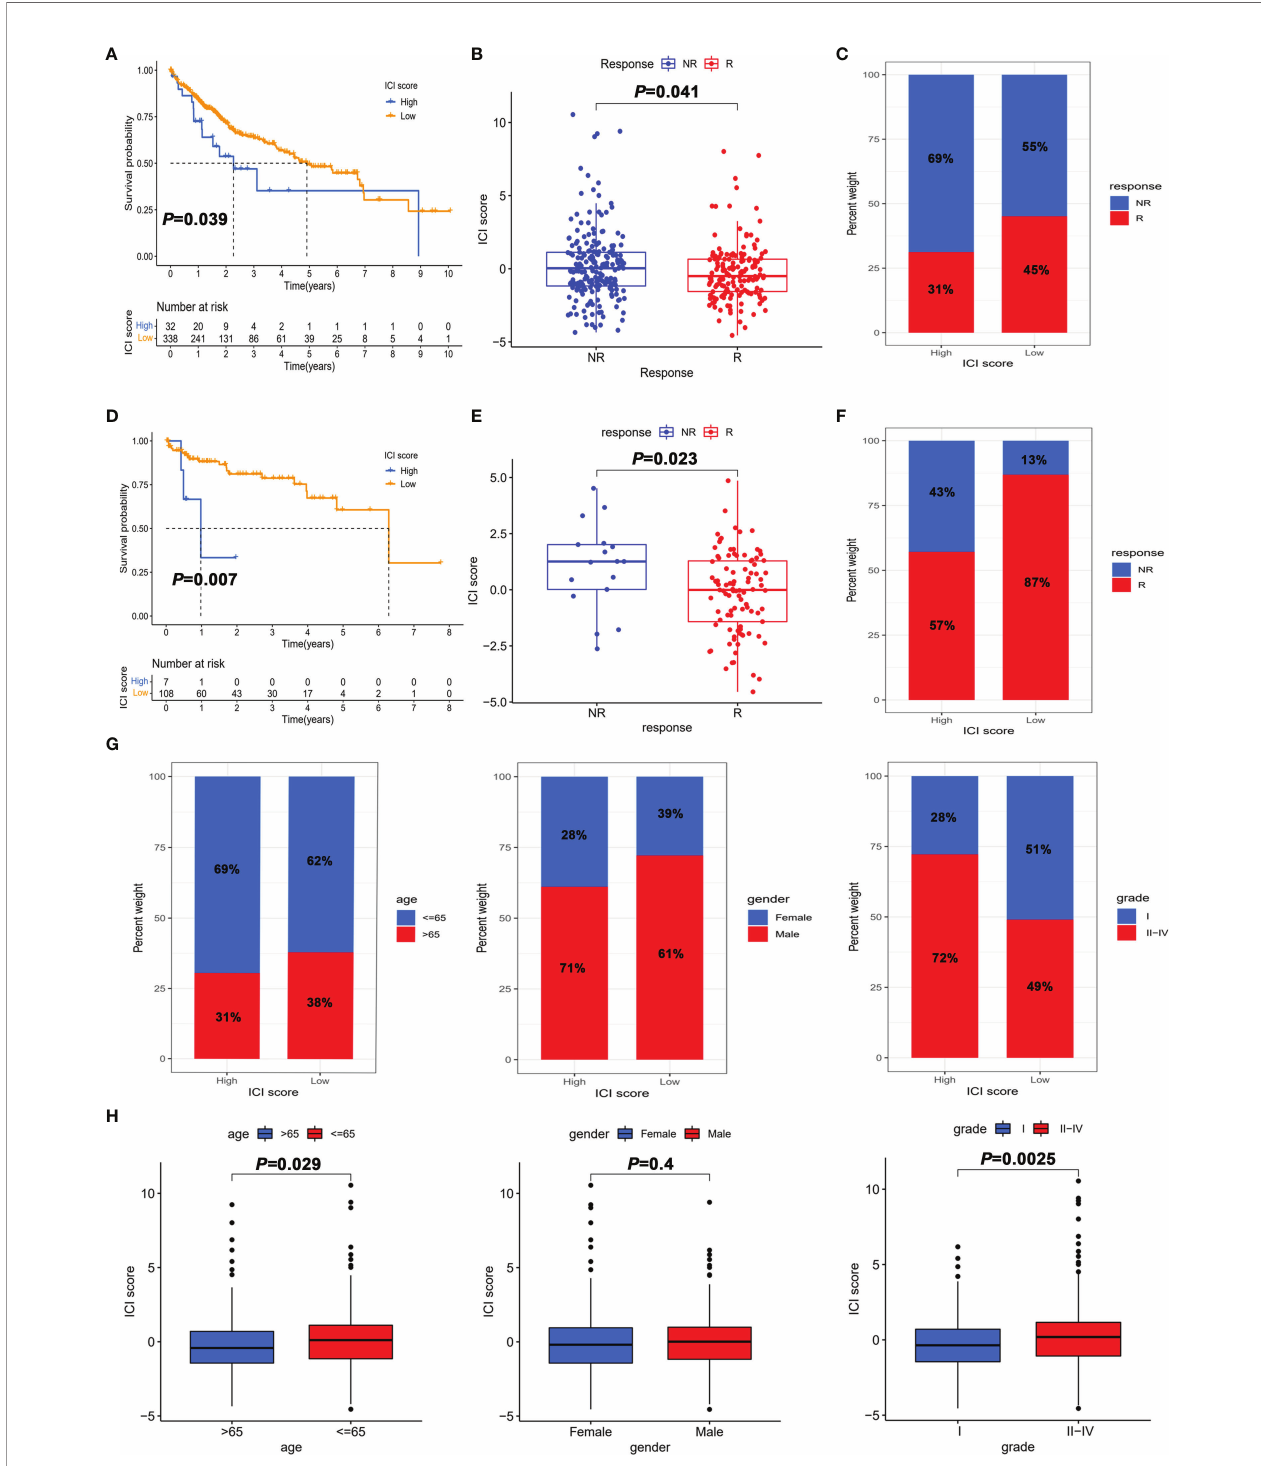
FIGURE 5 | The role of the ICI score in the prediction of immunotherapeutic bene fi ts. (A) Kaplan – Meier curves for patients with high and low ICI score in the TGCA-LIHC cohort. (B) Comparison of the ICI score in response and non-response to immunotherapy in the TGCA-LIHC cohort. (C) Percentage of objective response rate to immunotherapy for high score and low score groups in the TGCA-LIHC cohort. (D) Kaplan – Meier curves for patients with high and low ICI scores in the GSE76427 cohort. (E) Comparison of ICI scores in response and non-response to immunotherapy in the GSE76427 cohort. (F) Percentage of objective response rate to immunotherapy for the high score and low score groups in the GSE76427 cohort. (G) Percentage of clinical parameters for high score and low score groups. (H) Comparison of clinical parameters between high score and low score